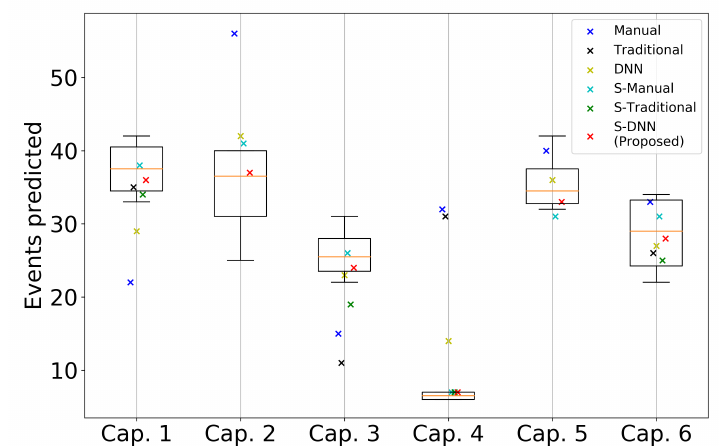
Figure 7. Prediction variability for the capillary videos using all the different segmentation methods. The x -axis denotes the index of each capillary from videos 1 to 3, and the y -axis the number of predicted events. Each ‘ × ’ mark indicates the number of predicted events using the corresponding segmentation and video stabilization. The boxplot for each capillary is obtained from the events counted by four